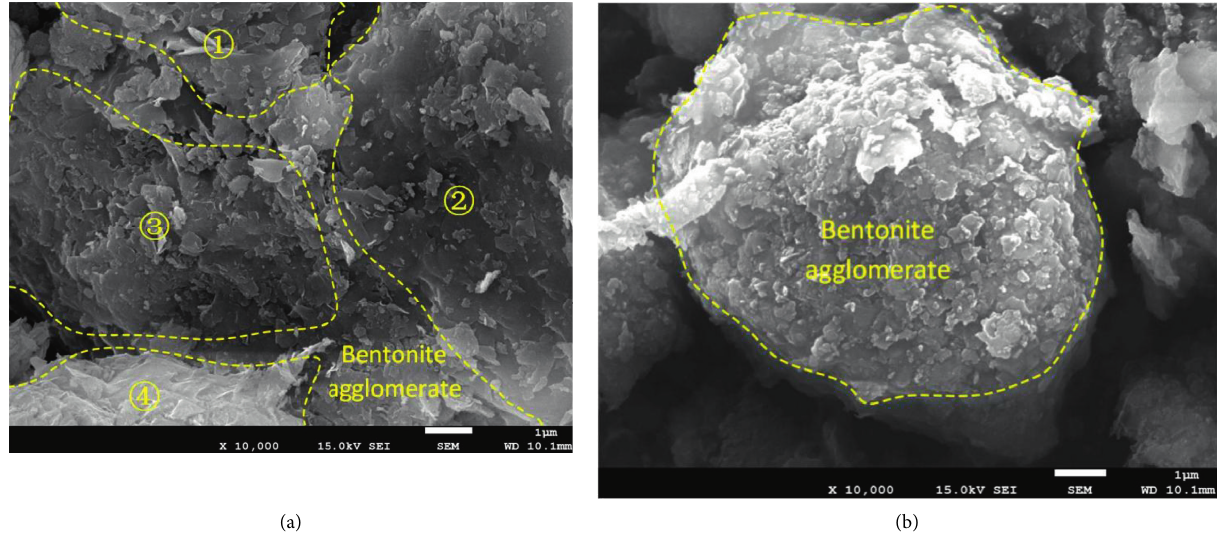
Figure 9: SEM photographs of original and granular bentonites. (a) Original bentonite ( X10000) and (b) granular bentonite (